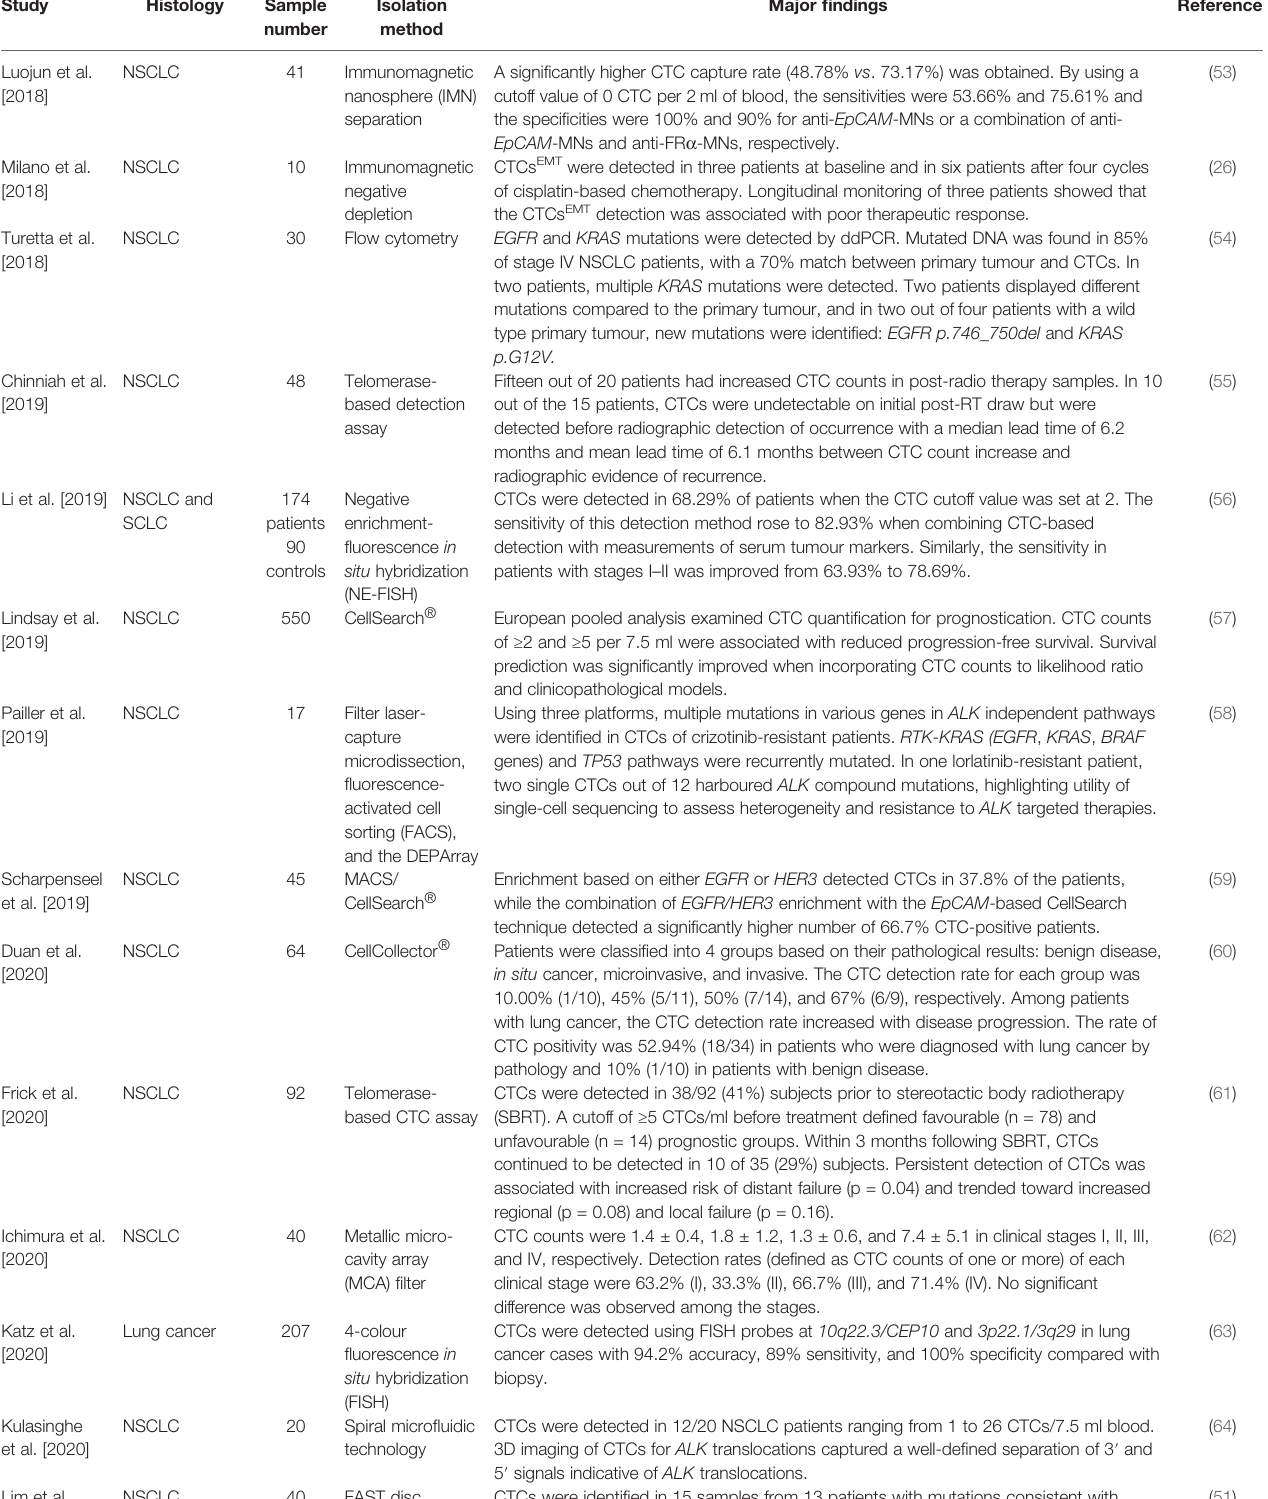
TABLE 1 | Circulating tumour cell studies in lung